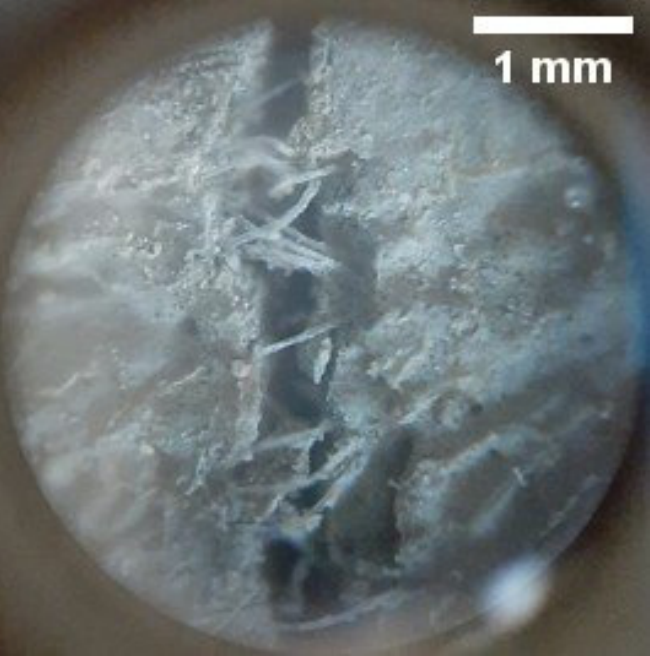
Figure 5. The appearance of a crack in a specimen subjected to the flexural test at 40× magnification. In addition, following the flexural tensile tests, the fractal dimensions of cracks were determined. Images of the samples after the flexural testing were firstly captured using a high-resolution camera. Then, these images were converted from RGB mode to an 8 bytes greyscale and scaled up to reflect the actual dimensions. The main flexural bending moment-induced cracks at the same point for all the samples were digitized for thresholding using open-access digital image analysis software called Image J. Then, these were covered by imaginary meshes with rectangular box sizes containing the number of pixels of the crack image (Figure 6). Next, the number of grid squares to cover the cracks was counted for the plot of In (box count) versus In (box size), which were used to compute the average value of fractal dimension that is the slope of the line joining the logarithm of the number of grid squares encountered by the crack and the logarithm of the square grid dimension. Then, using the formula established by Guo et al. [45], the composites’ dissipated fracture energy (Ws/Gf) was approximated at the macro scale as a function of the surface macro-cracks. The ratio of energy (Ws) produced by crack propagation to fracture energy (Gf) is shown by the value of Ws/Gf.